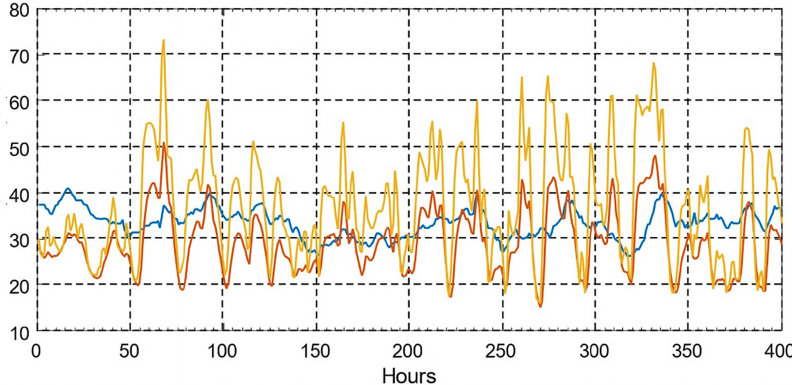
Figure 46. Temperature was available in online data (blue) and estimated top oil (orange) and hot spot (yellow)